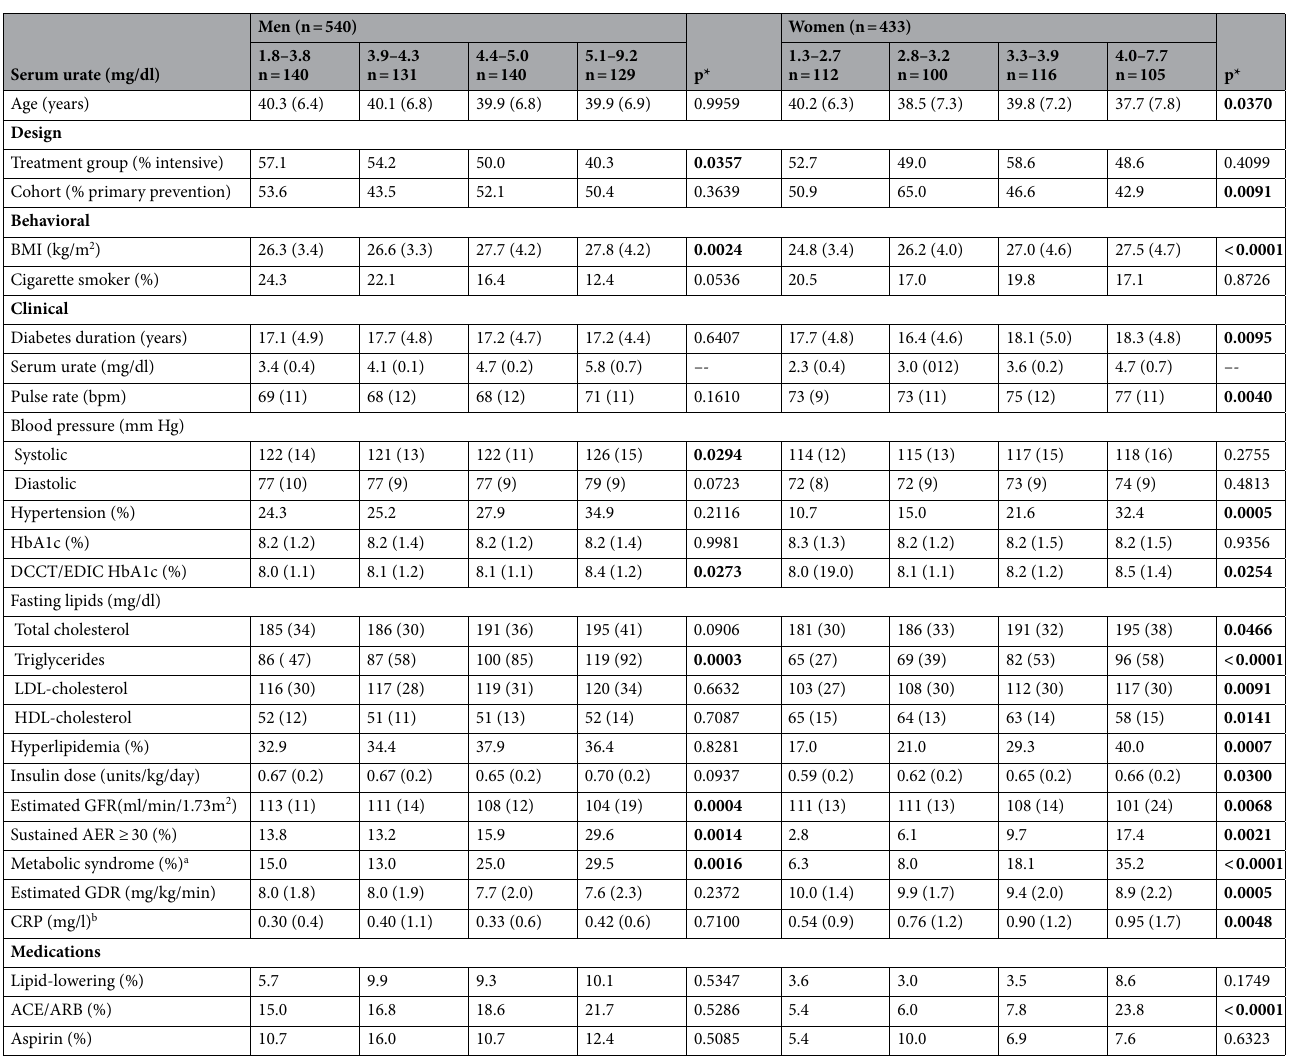
Table 1. EDIC participant characteristics by quartiles of SU in men and women (at time of SU sampling, 1997–2000). Data are means (SD) or %. Quartile groups are not equal in sample size due to the discrete nature of the data and the presence of ties. SU serum urate, BMI body mass index, LDL low-density lipoprotein, HDL high-density lipoprotein, GFR glomerular filtration rate, AER albumin excretion rate, GDR glucose variables. a Metabolic syndrome is defined as having two or more of the following four during EDIC: